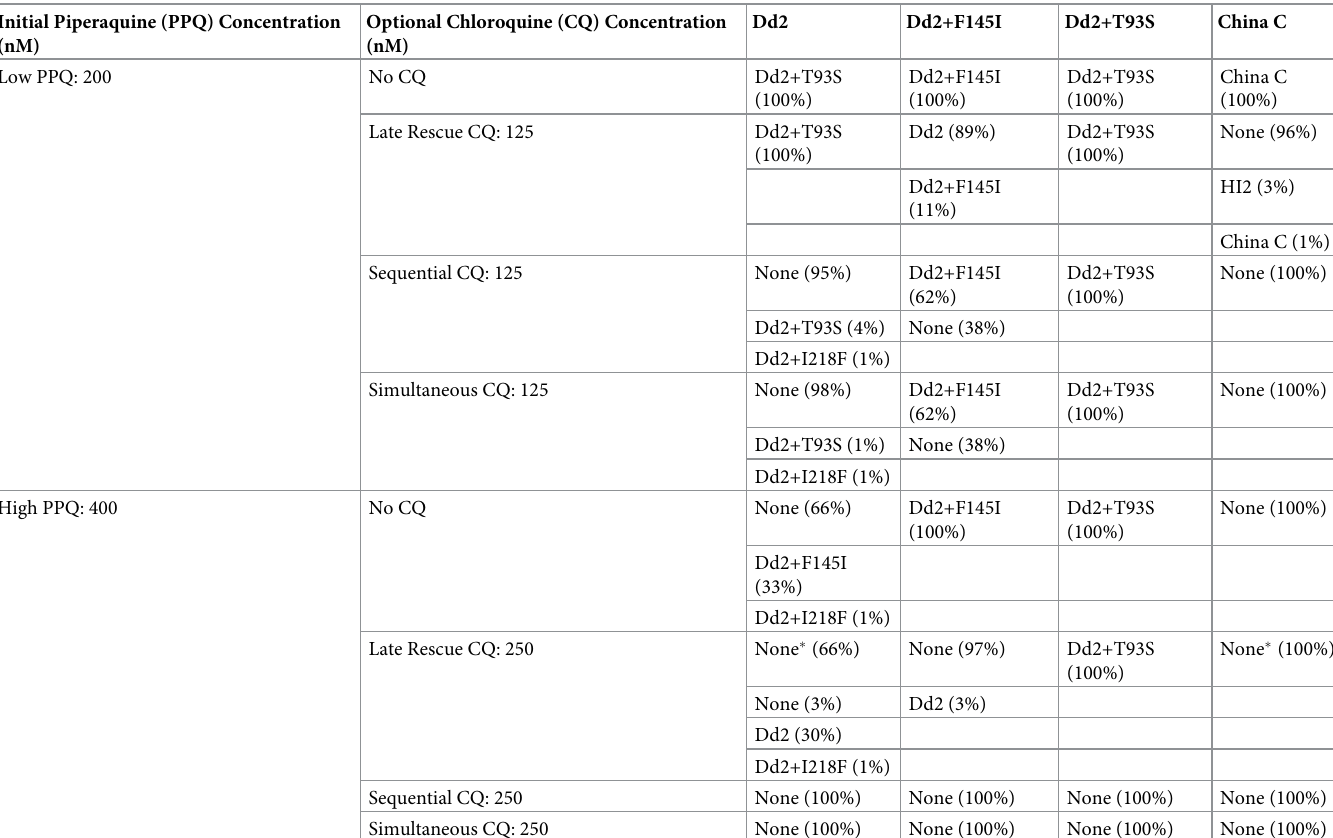
Table 2. Summary of simulation outcomes for single strain infections of Dd2 Dd2 , Dd2 Dd2+F145I , Dd2 Dd2+T93S , and Dd2 China C . Initial Piperaquine (PPQ) Concentration